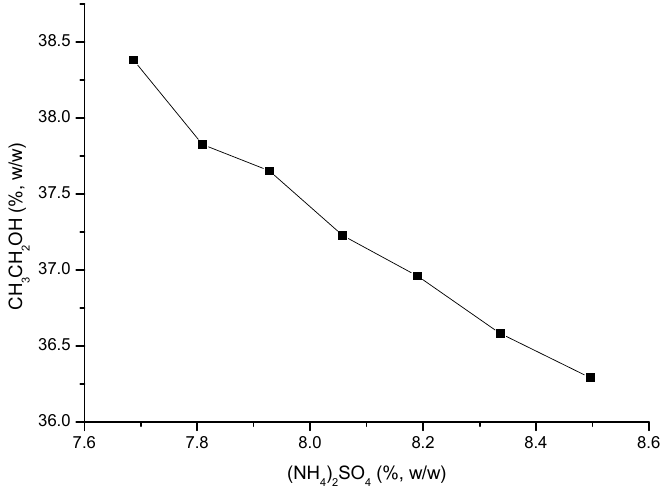
Figure 2. The phase diagram of osmosis extraction (OE) with the ethanol / (NH 4 ) 2 SO 4 system.